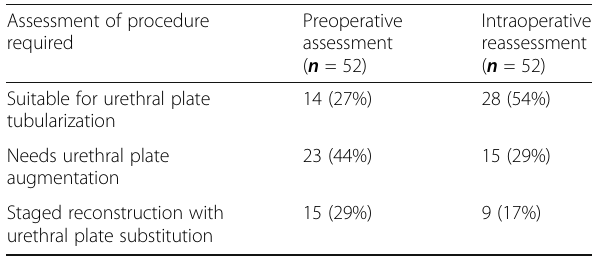
Table 1 Age of the patients at surgery Age of the patient at surgery